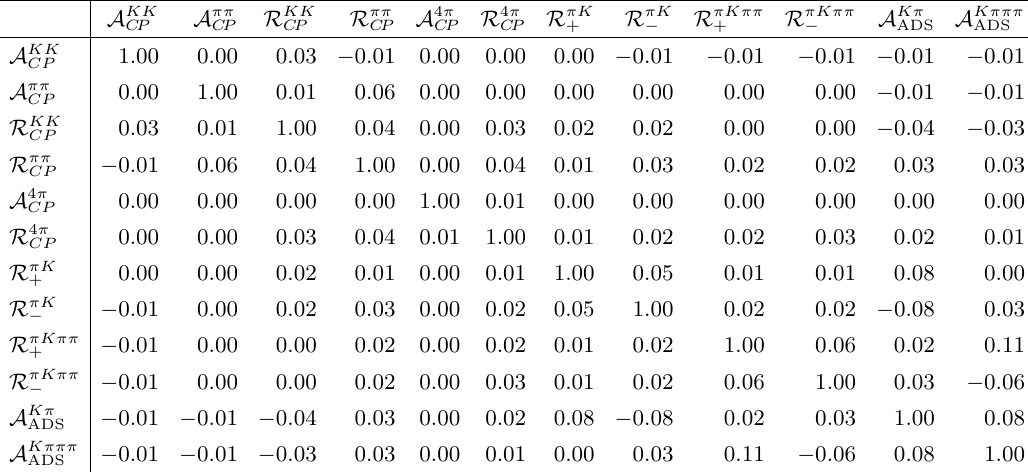
Table 4 . Combined statistical and systematic correlation matrix for the principal observables.